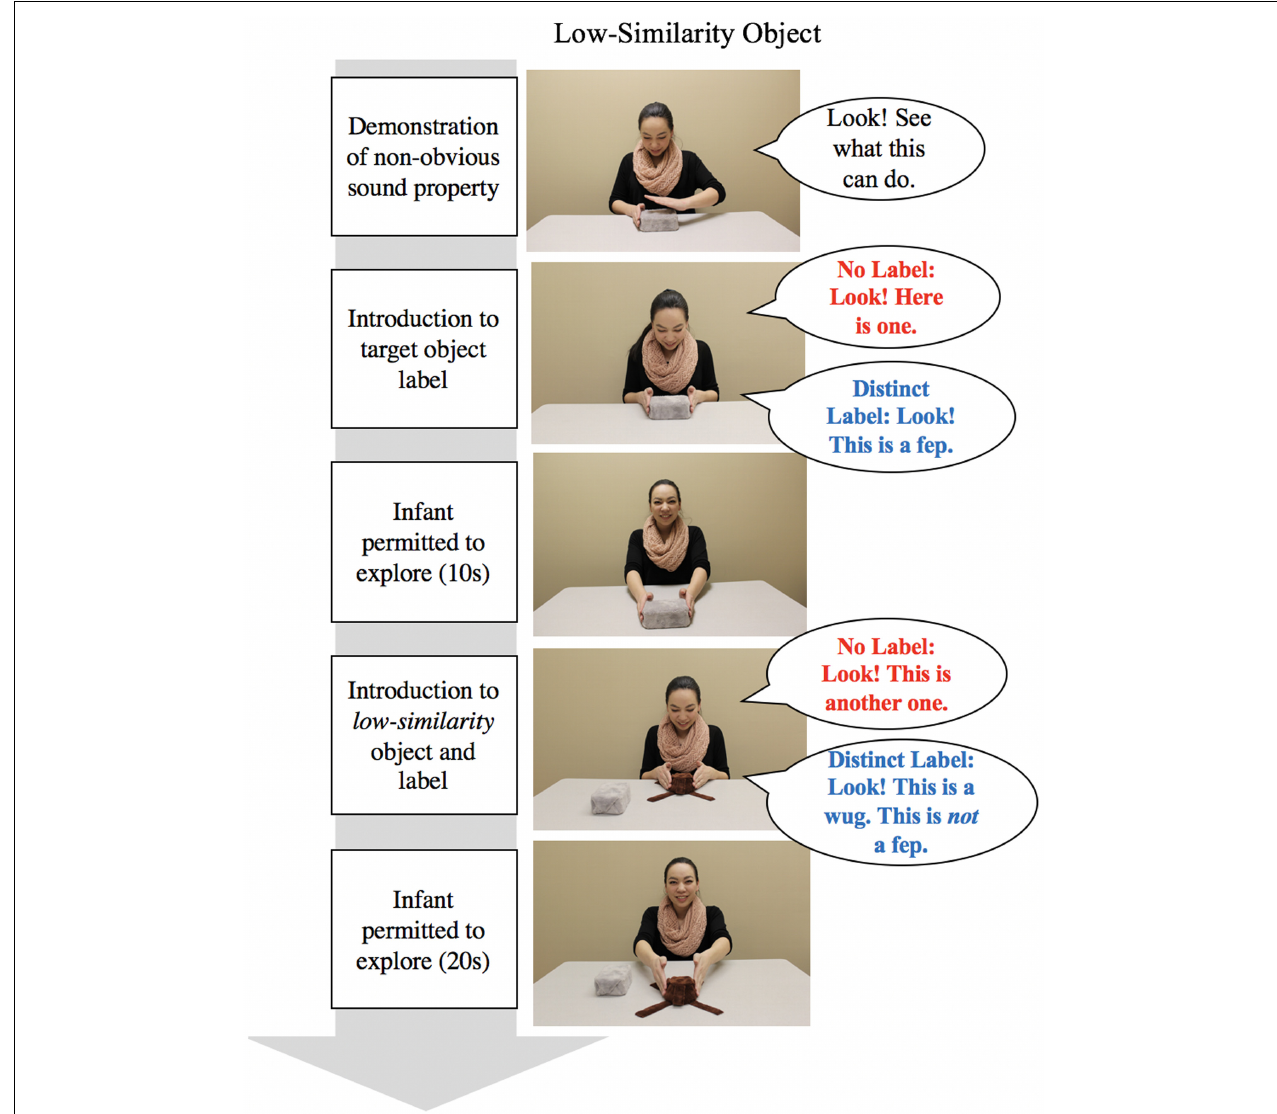
FIGURE 3 | Overview of inductive inference test procedure for low similarity test objects with example dialog. Please see “Procedure” section for full details of the dialog.